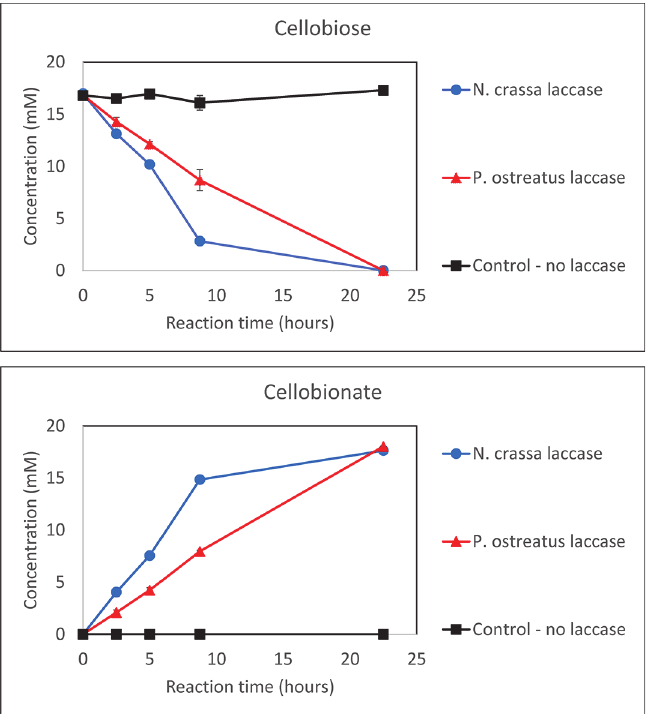
Fig 6. Comparison of the N . crassa laccase to the P . ostreatus laccase in the conversion of cellobiose to CBA using the CDH-ABTS-laccase conversion system. The data shown are the means of biological duplicates with the error bars representing the standard